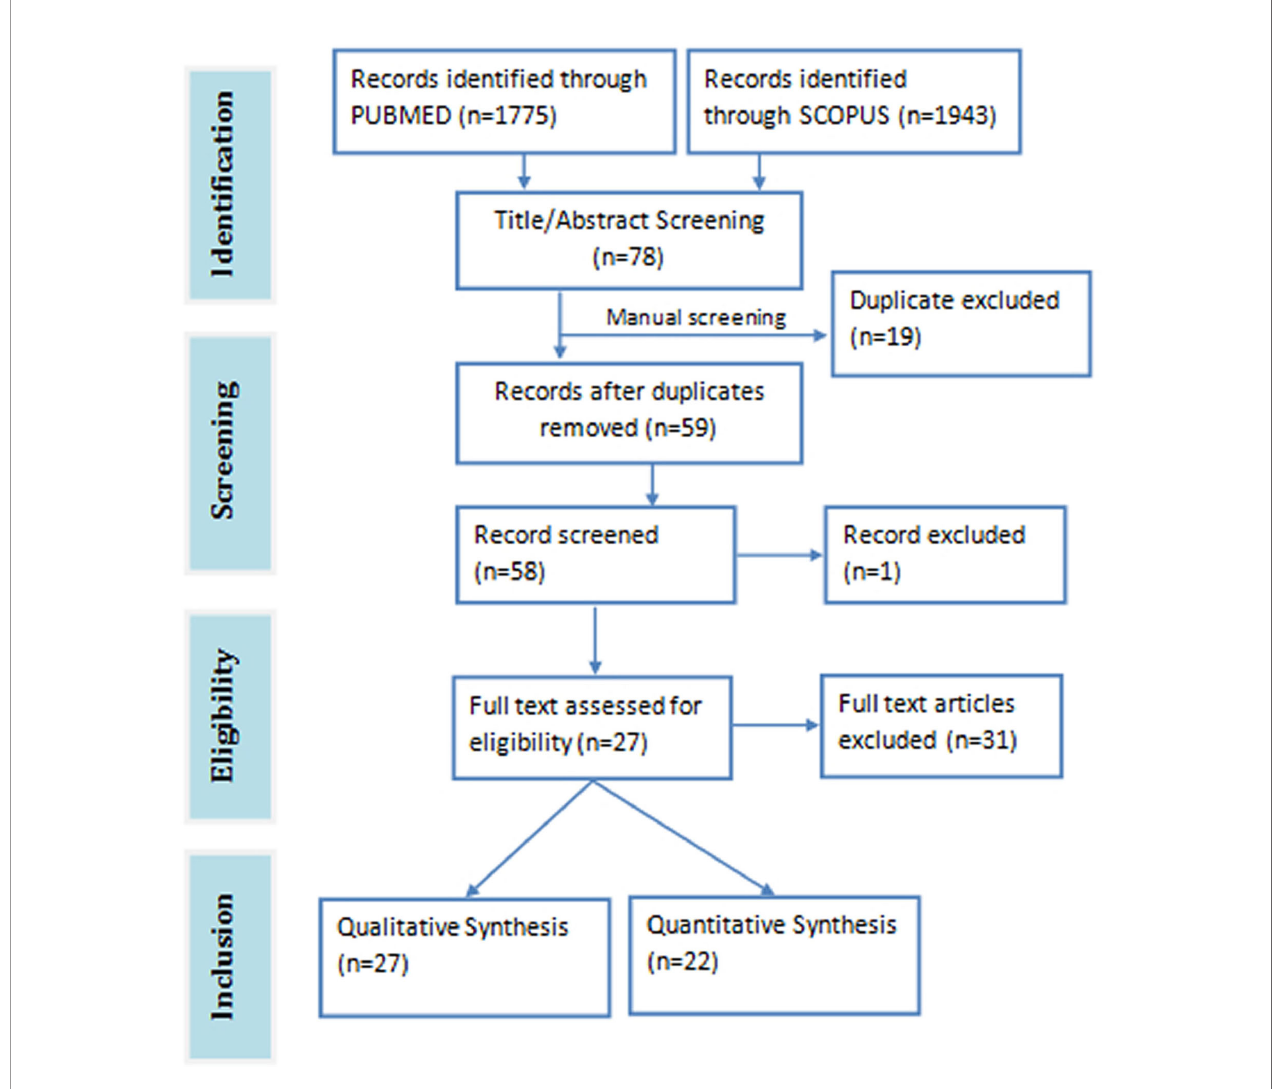
FIGURE 1 | Prima fl owchart of included studies.